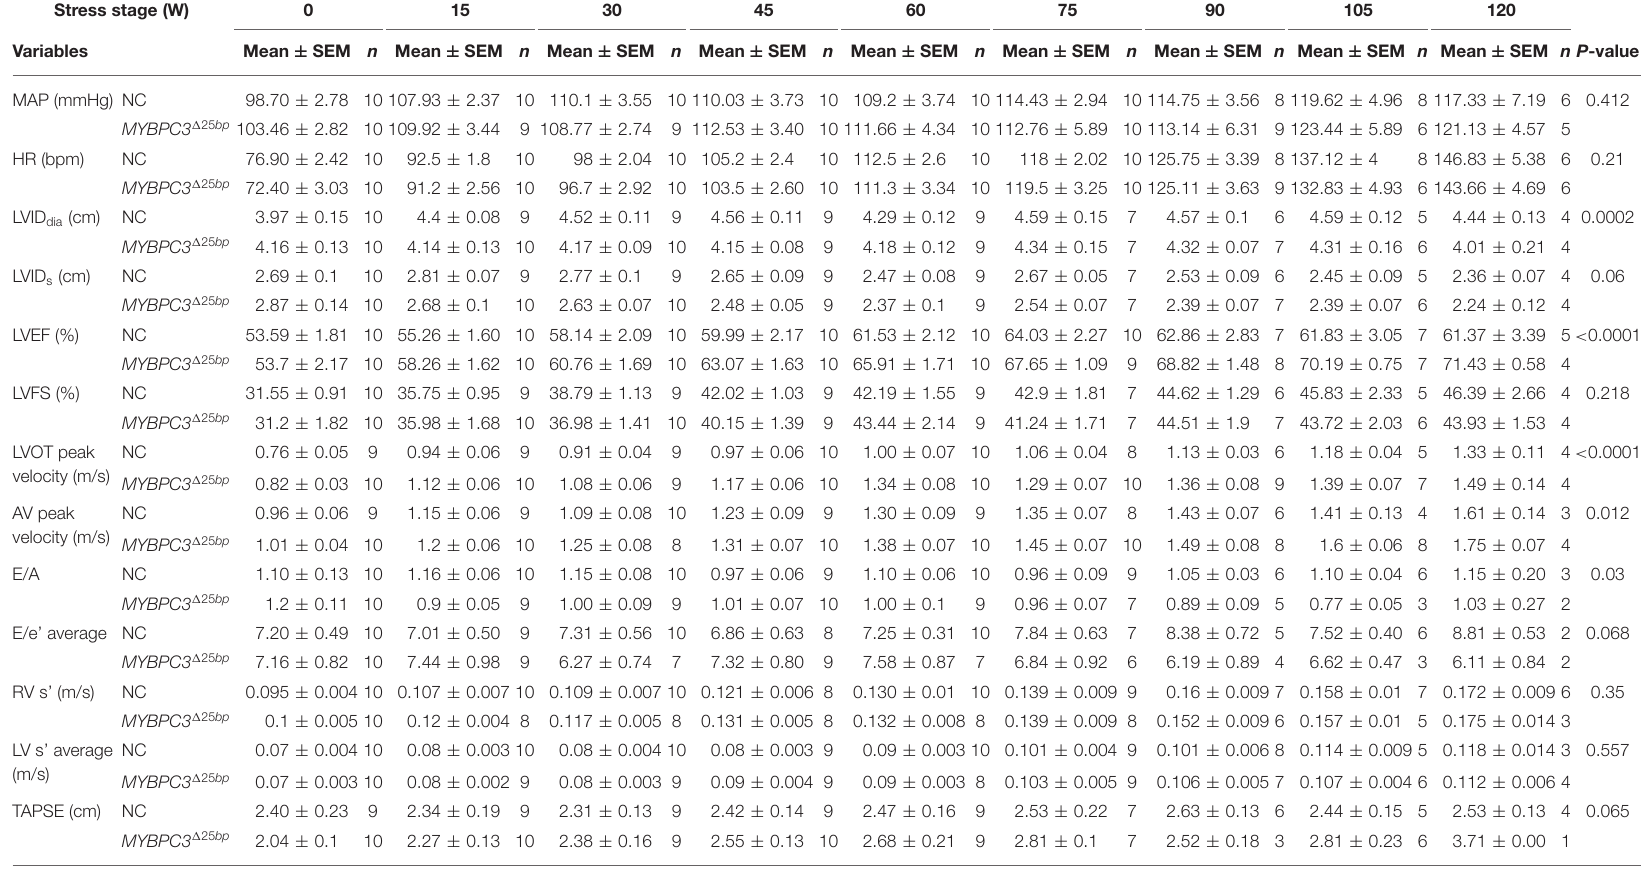
TABLE 2 | Clinical and bicycle exercise echocardiography parameters of 20 South Asian